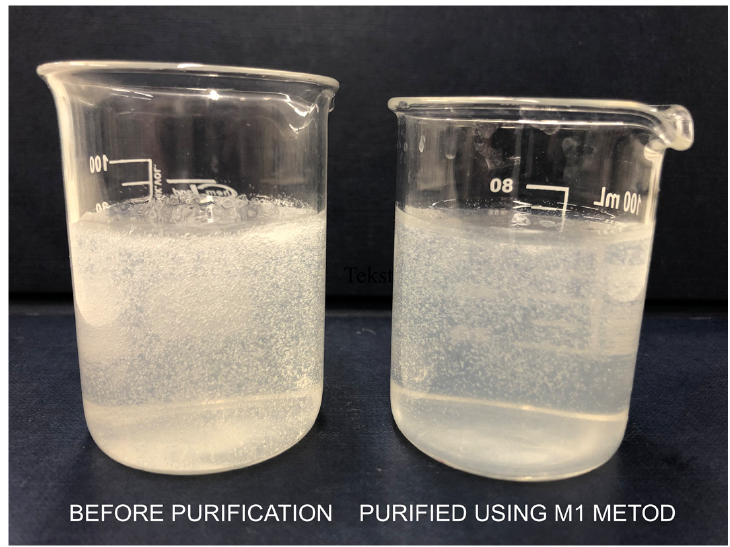
Figure 2. Comparison of the appearance of chitosan hydrogel samples before and after treatment with M1 method.